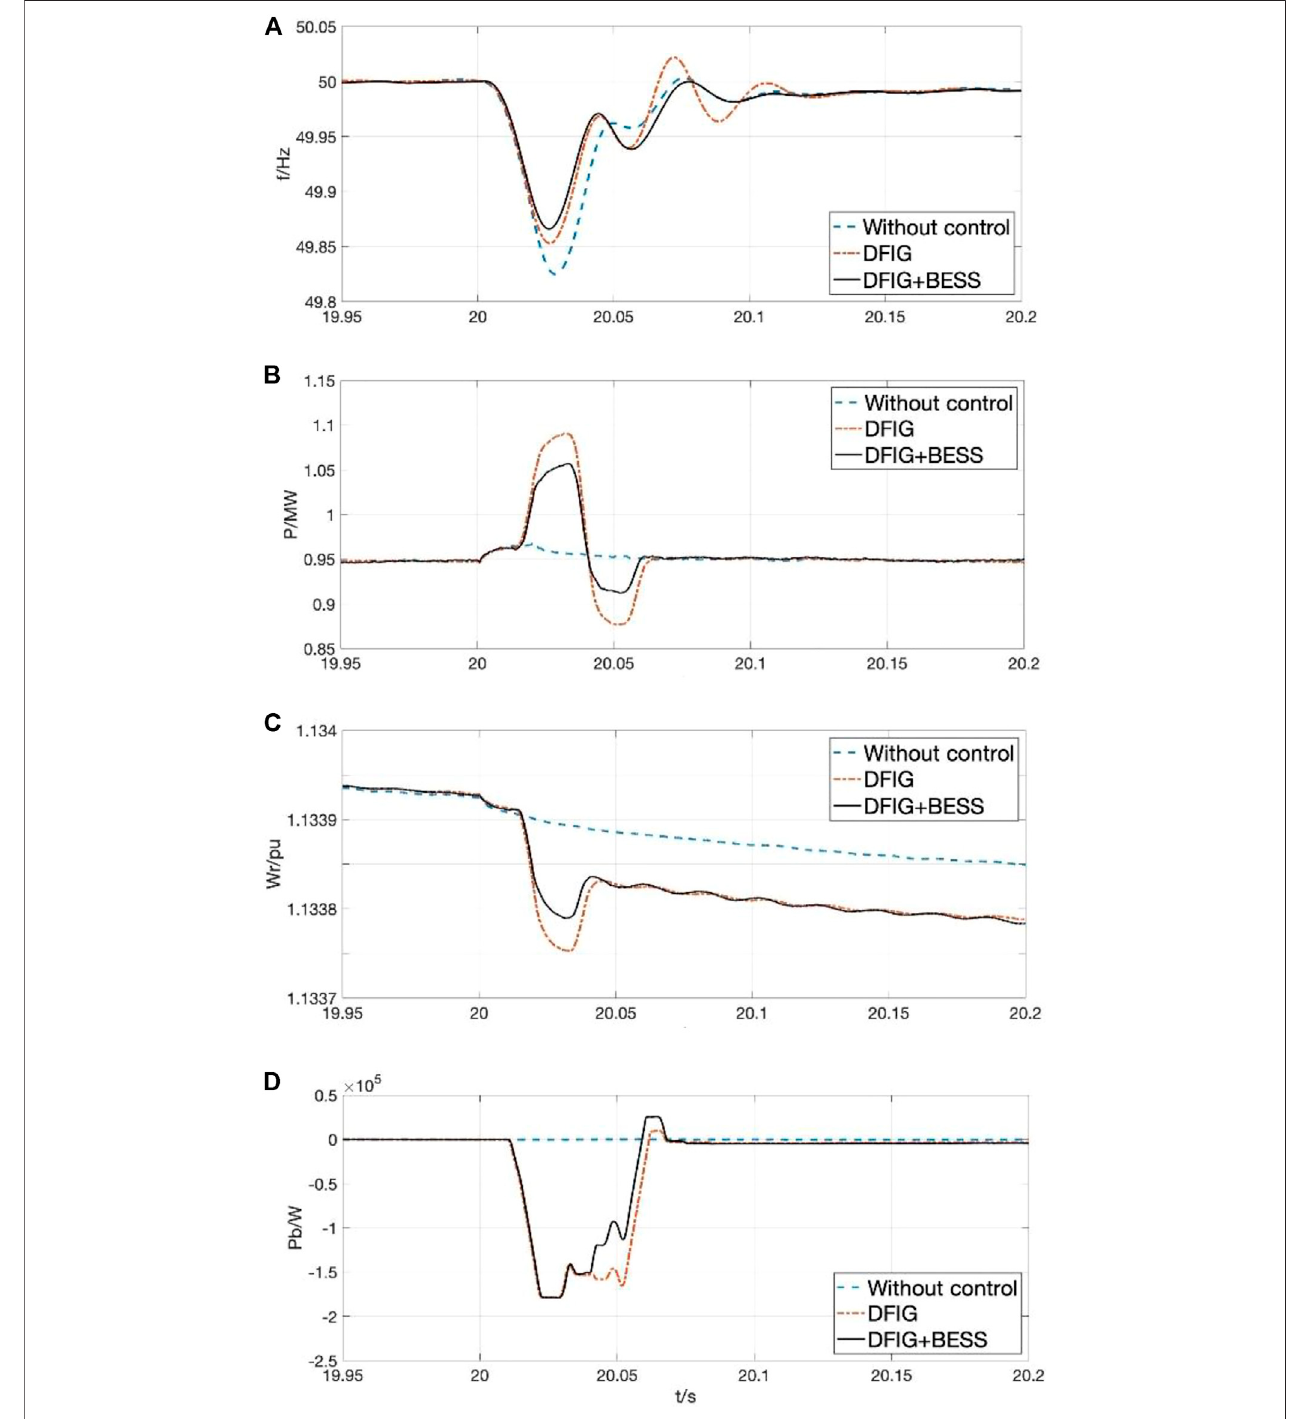
FIGURE 8 | Results for case 2. (A) system frequency. (B) turbine output power. (C) rotor speed. (D) output power of the BESS.